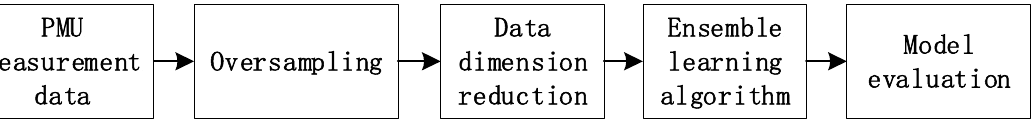
Figure 6. The framework of the network attack detection method.